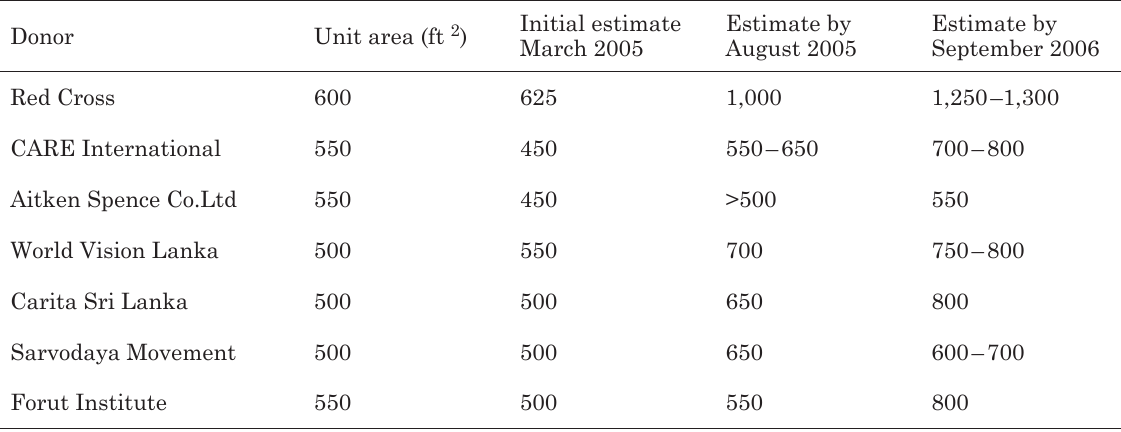
table 2. construction cost estimation over time (thousand rupees)